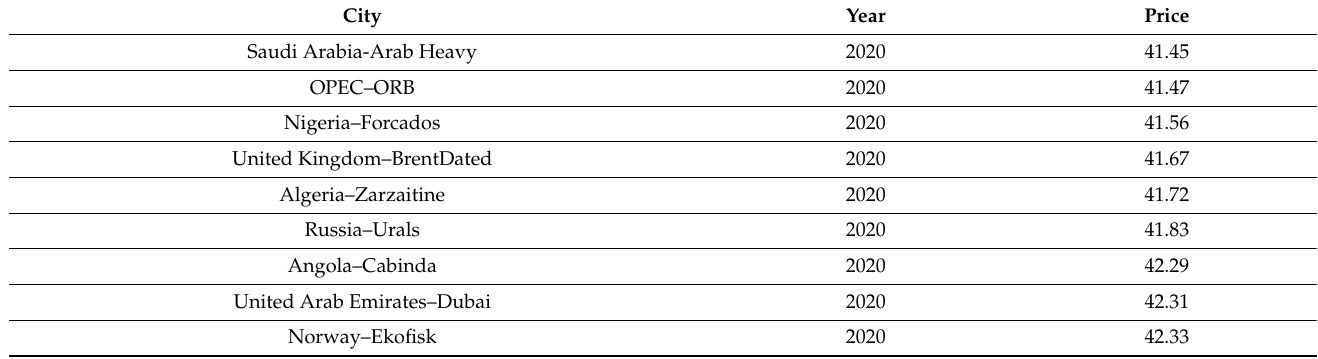
Table 1. Selected spot crude oil prices ($/b) Yearly.